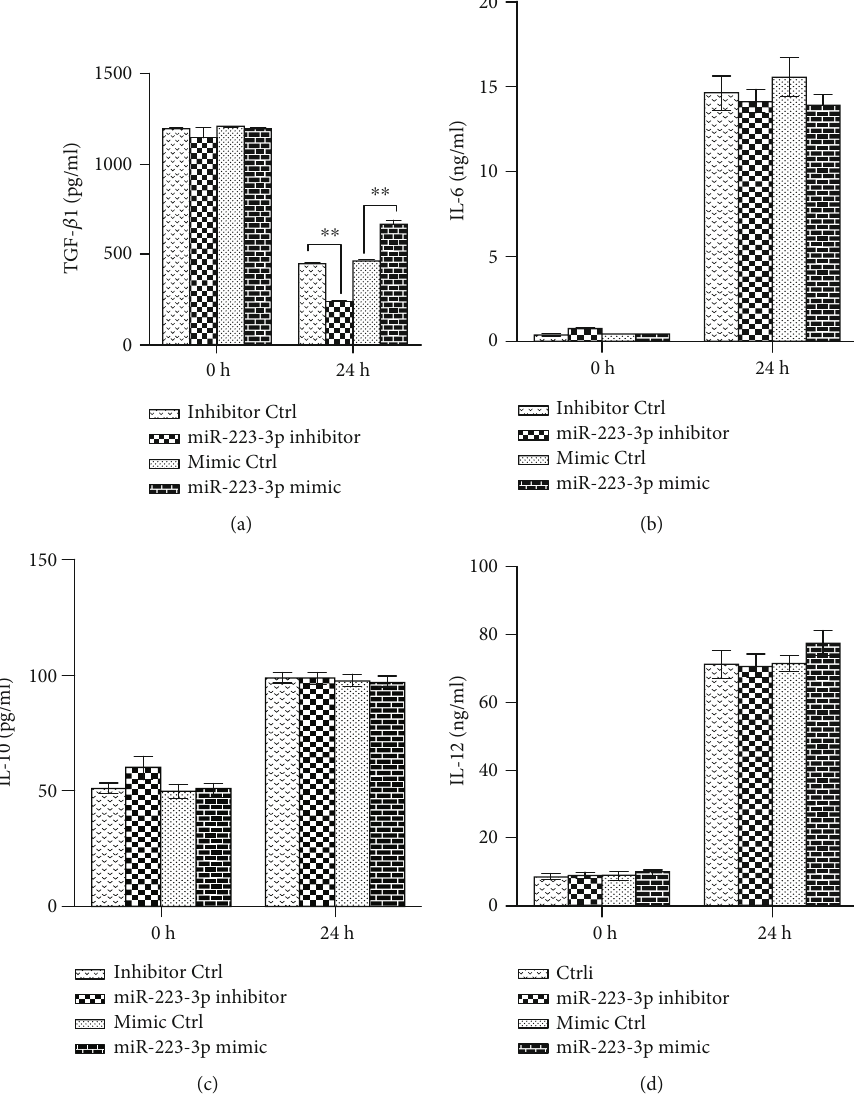
Figure 4: miR-223-3p regulated TGF- β 1 production in OVA-induced DCs. Immature mouse DCs transfected with the miR-223-3p inhibitor, inhibitor control, miR-223-3p mimic, or mimic control at a fi nal concentration of 50nM. After 24h, DCs were stimulated with 100 μ g/ml OVA for 24h. TGF- β 1 (a), IL-6 (b), IL-10 (c), and IL-12 (d) levels in the supernatants were measured by ELISA. Data were shown as mean ± SD of three independent experiments. Post hoc Tukey ’ s HSD test, ∗ P < 0 : 05 , ∗∗ P < 0 : 01